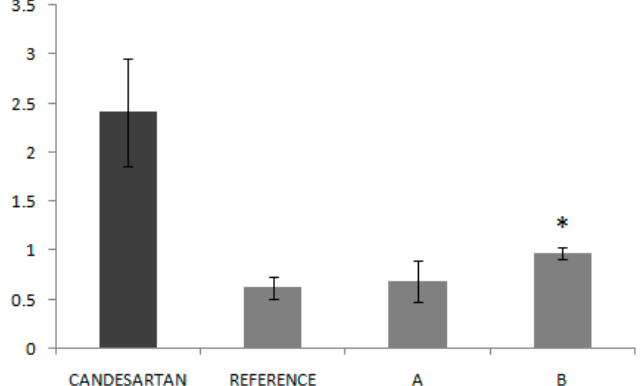
Figure 3. Absorption rates (k a ) obtained experimentally for the API candesartan cilexetil and candesartan cilexetil products (Reference, Product A and Product B). * indicates that there is a statistically significant difference between Product B and the other two products.